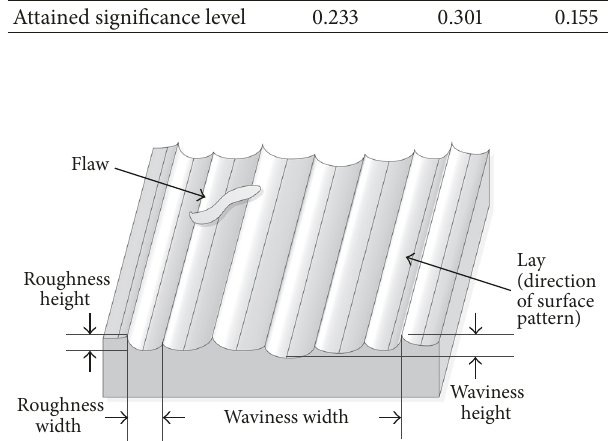
Figure 2: Roughness and waviness